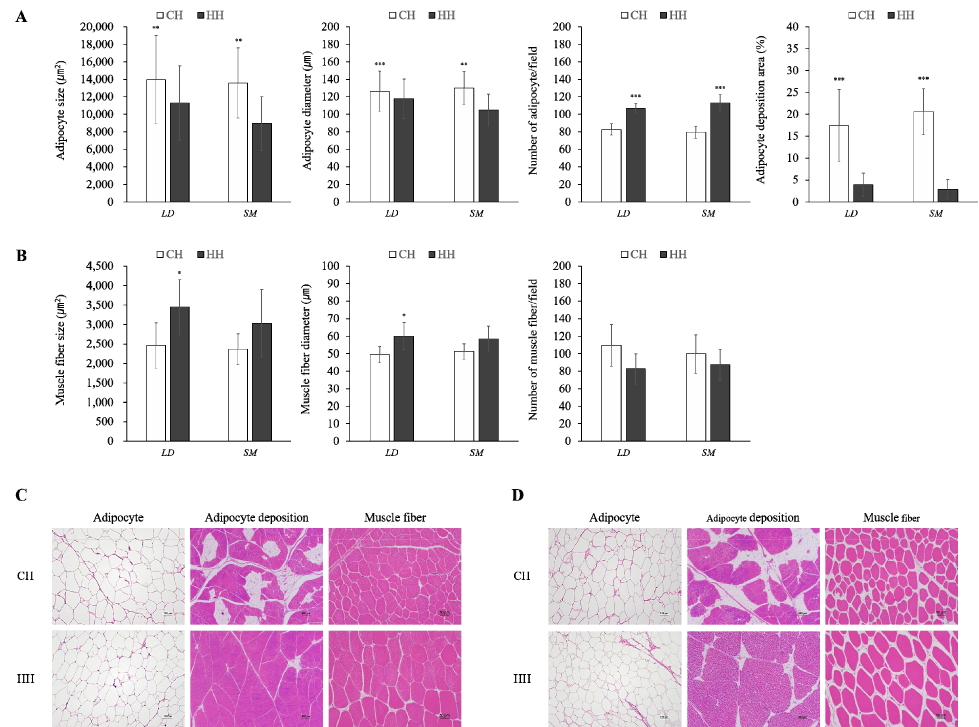
Figure 2. Characteristics of adipocytes ( A ) and muscle fibers ( B ) in skeletal muscle from castrated (CH: □ ) and hemi- castrated (HH: ■ ) Hanwoo (* p < 0.05; ** p < 0.01; *** p < 0.001; mean ± SD). ( C , D ) Representative images of adipocyte (100-fold), adipocyte deposition (20-fold), and muscle fiber (200-fold) stained with hematoxylin and eosin (( C ) = LD, ( D ) = SM). Table 4. Comparison of economy efficacy on castrated and hemi-castrated